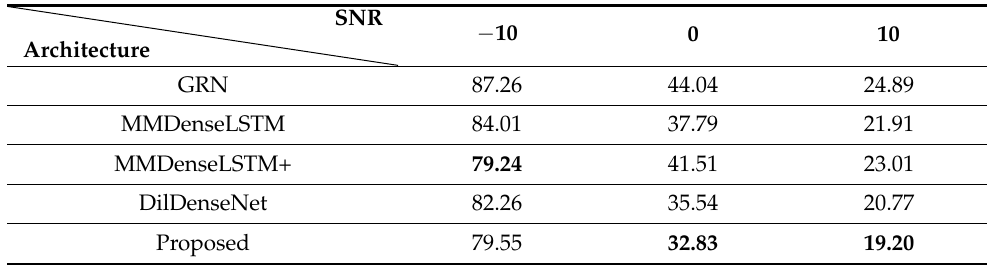
Table 5. Average word error rate (WER) over the entire signal-to-music ratio (SMR) at each signal-to- noise ratio (SNR). Lower WER indicates better